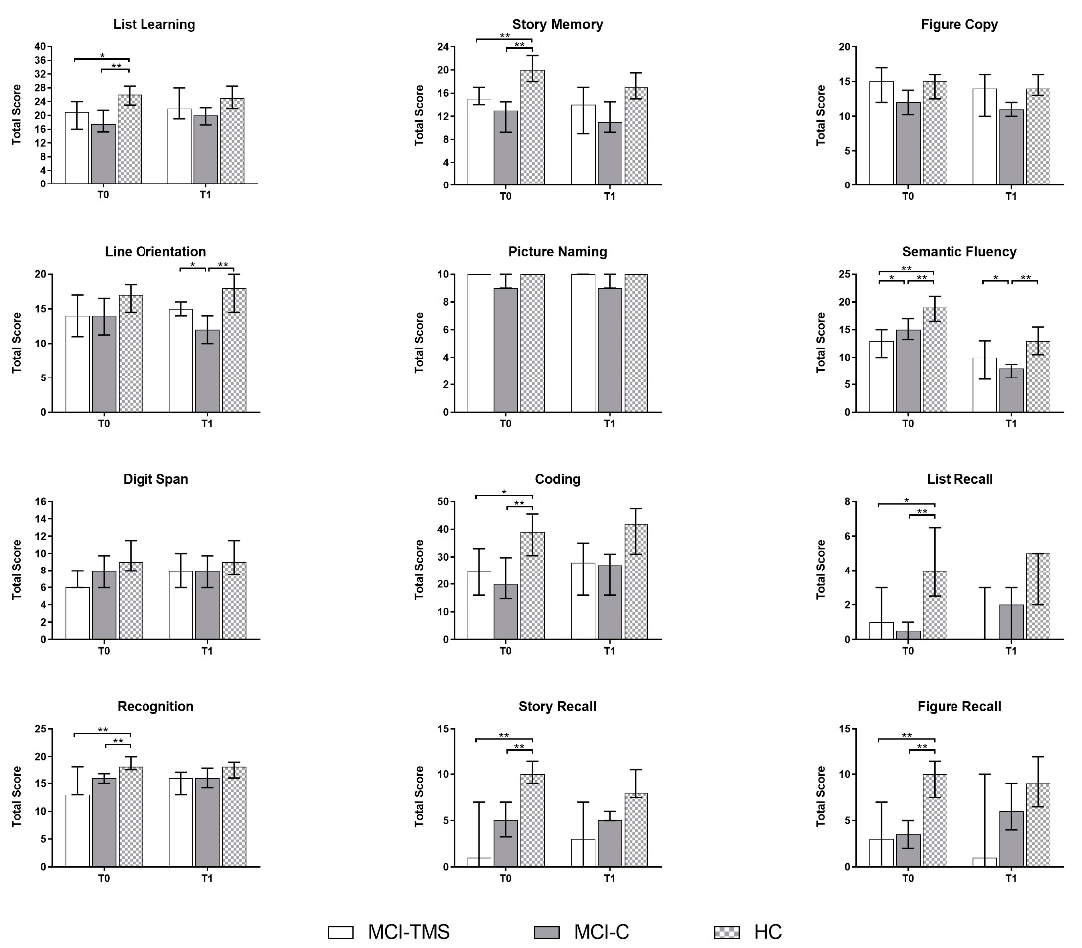
Figure 2. Between-group comparison on Repeatable Battery for the Assessment of Neuropsychological Status (RBANS) sub-tests at T0 and T1 (pre- and post-treatment) using Quade’s rank analyses of covariance; Benjamini–Hochberg-corrected * p ≤ 0.05, ** p ≤ 0.01.